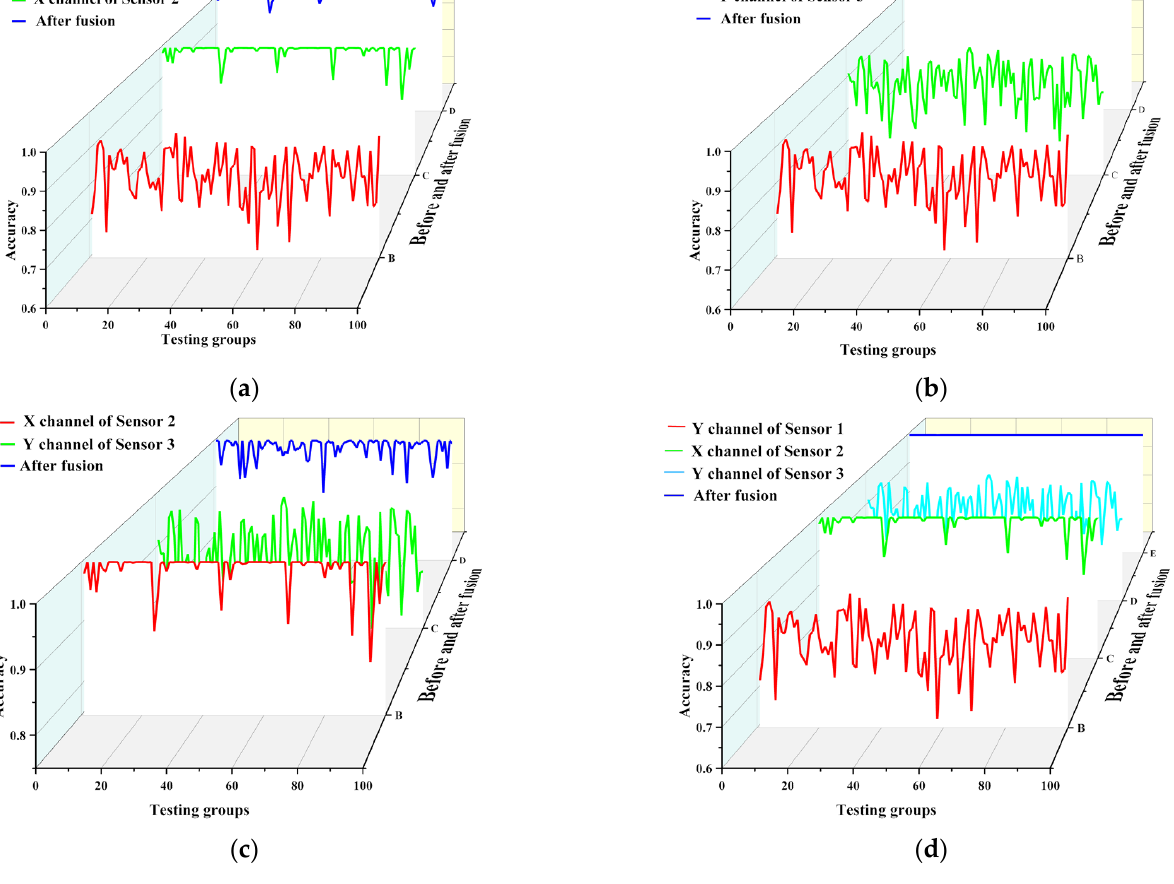
Figure 13. Before and after single-channel sensor fusion. ( a ) sensor 1 and sensor 2 fusion; ( b ) sensor 1 and sensor 3 fusion; ( c ) sensor 2 and sensor 3 fusion; and ( d ) 3 sensors fusion.